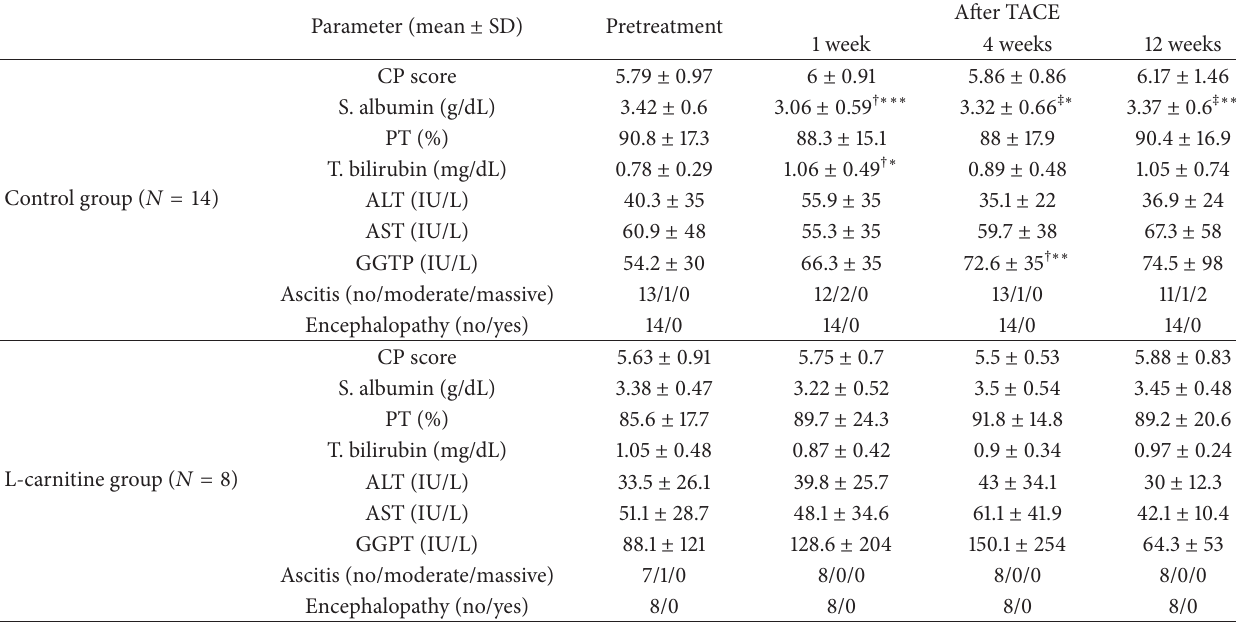
Table 4: Effects of L-carnitine in BCAA −